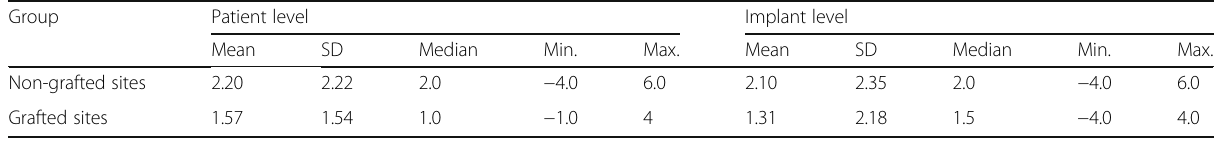
Table 4 Reduction of maximum PD (mm)